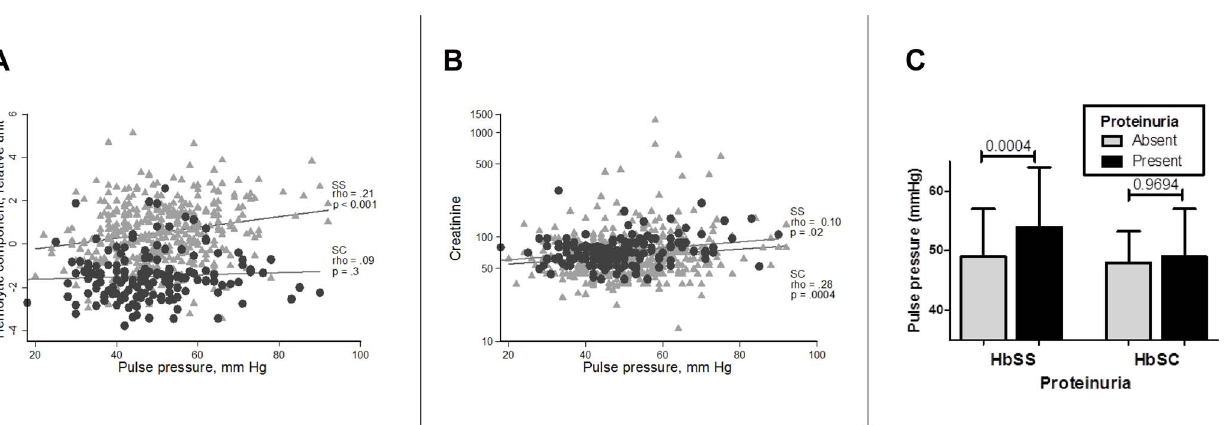
Figure 1. Correlates and associations of pulse pressure with kidney function and hemolysis. A , Pulse pressure has a significant positive correlation with the hemolytic component in HbSS patients, but not in HbSC patients. B , Pulse pressure has a significant positive correlation with serum creatinine in both HbSS and HbSC patients. C , Elevated pulse pressure is significantly associated with presence of proteinuria in HbSS patients, while the association is not significant in HbSC patients.